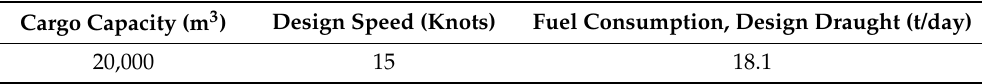
Table 9. The characteristics of a LNG carrier of 20000 m